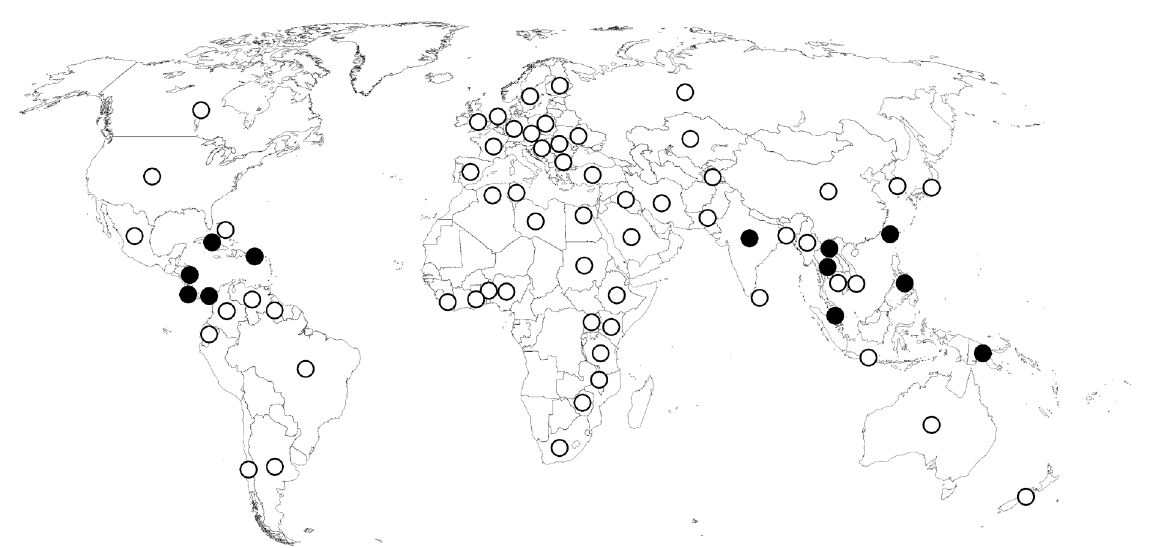
Fig. 4. Geographical distribution of the known records of Gallancyra dentata (Sugimoto, 1934), based on the reports cited in Table 1. Black circles indicate countries where G. dentata has been reported at in at least one survey, including the present report. Hollow circles indicate countries for which surveys of domestic chicken have been published, but G. dentata has not been found. In addition to the areas indicated on the map, Emerson (1956) reported G. dentata from “various islands in the Central Pacific Area”, but gave no